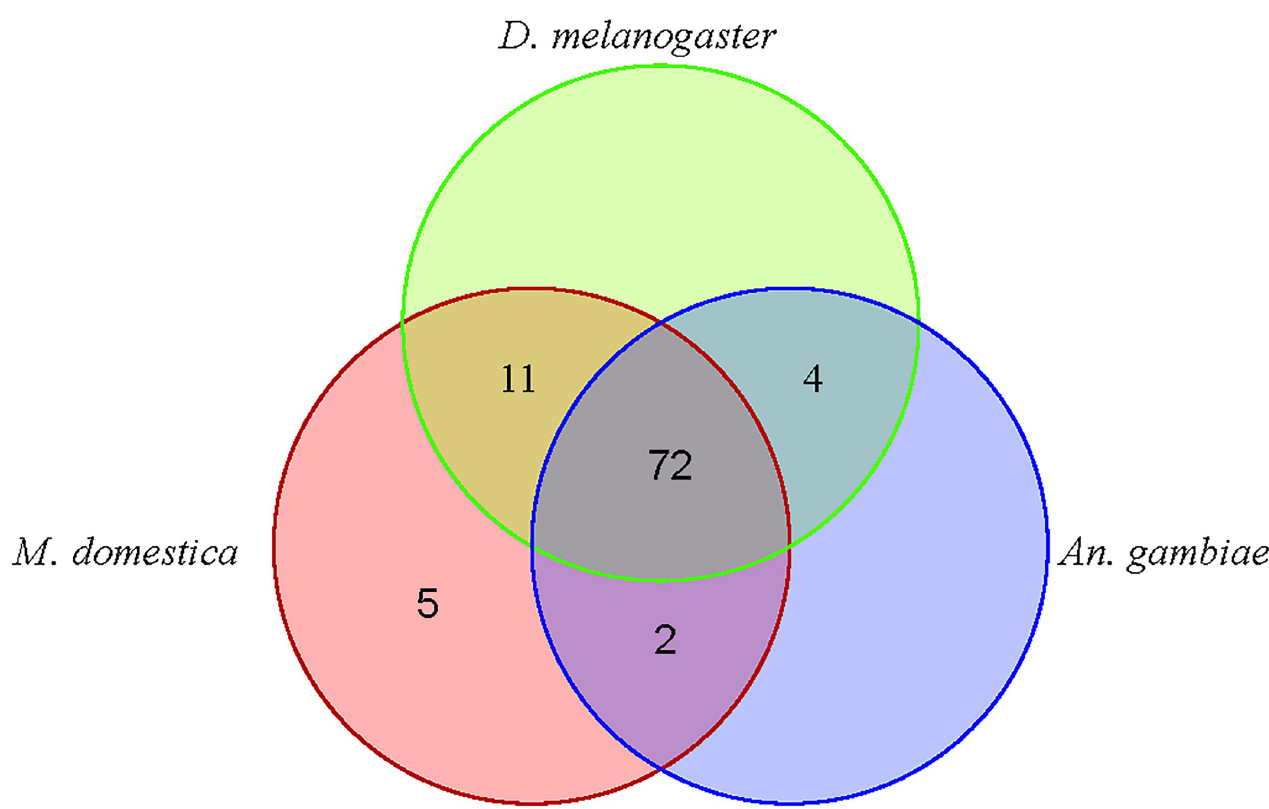
Fig 4. Orthologs of novel annotated male G . m . morsitans antennae genes in D . melanogaster , M . domestica and An . gambiae genomes .